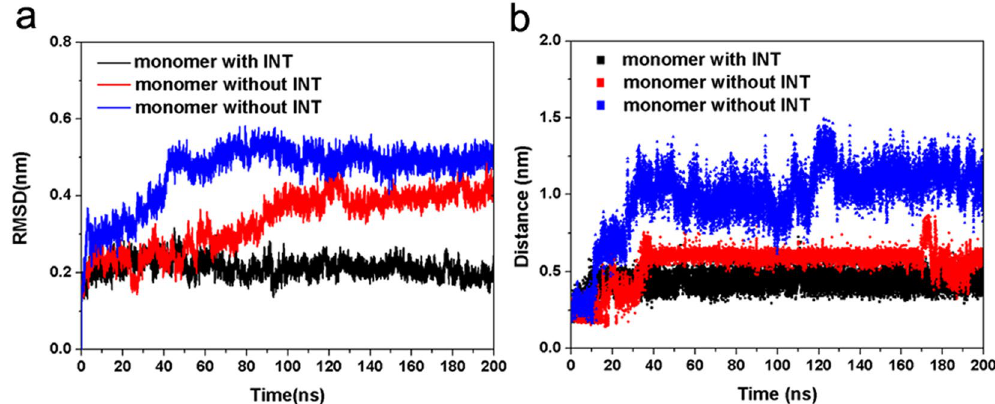
Figure 12. ( a ) RMSD plot of loop from HA bound with INT and free HA during 200 ns molecular dynamics simulations under acidic conditions. ( b ) Changes in distances of Glu101 and Lys50 during 200 ns molecular dynamics simulations under acidic